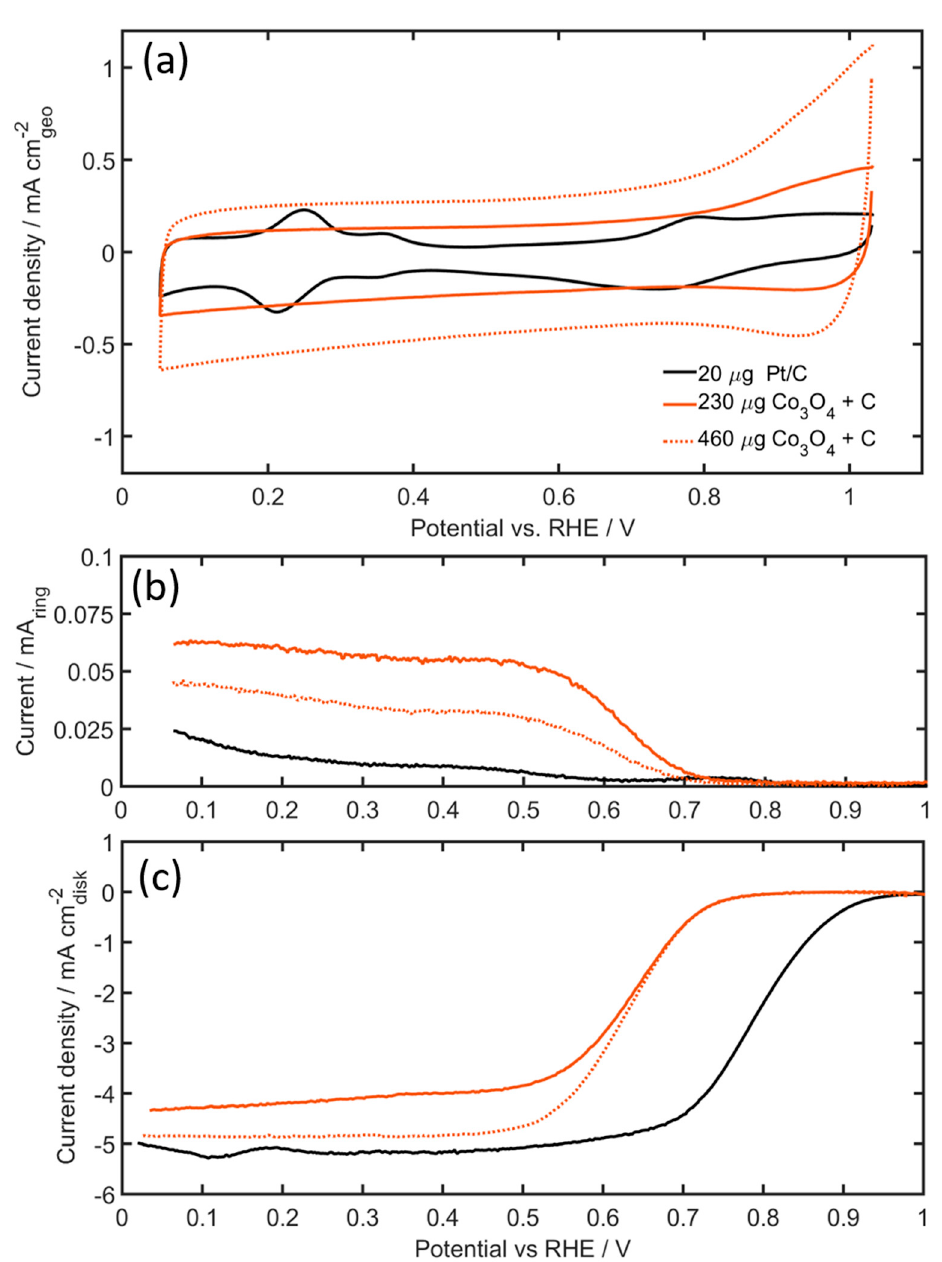
Figure 6. ( a ) Cyclic voltammograms of Pt/C and Co 3 O 4 + C (catalyst/carbon ratio = 1.25) in Ar-saturated electrolyte, ( b ) Rotating ring disk electrode (RRDE) ring current during ORR, and ( c ) disk current during ORR of Pt/C and Co 3 O 4 + C (catalyst/carbon ratio = 1.25) in O 2 -saturated electrolyte. Disk current are both iR corrected (using electrochemical impedance spectroscopy (EIS) and background corrected (using CV currents from Figure 6a). All measurements performed in 0.1 M KOH, rotating speed: 1600 rpm, scan rate: 20 mVs − 1 , using catalyst loadings of 20 µg Pt, 230, and 460 µg of Co 3 O 4 .